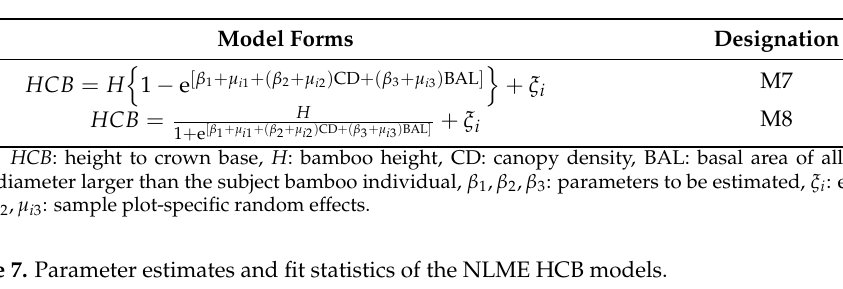
Table 6. Forms of the NLME HCB models with random effects added to them.